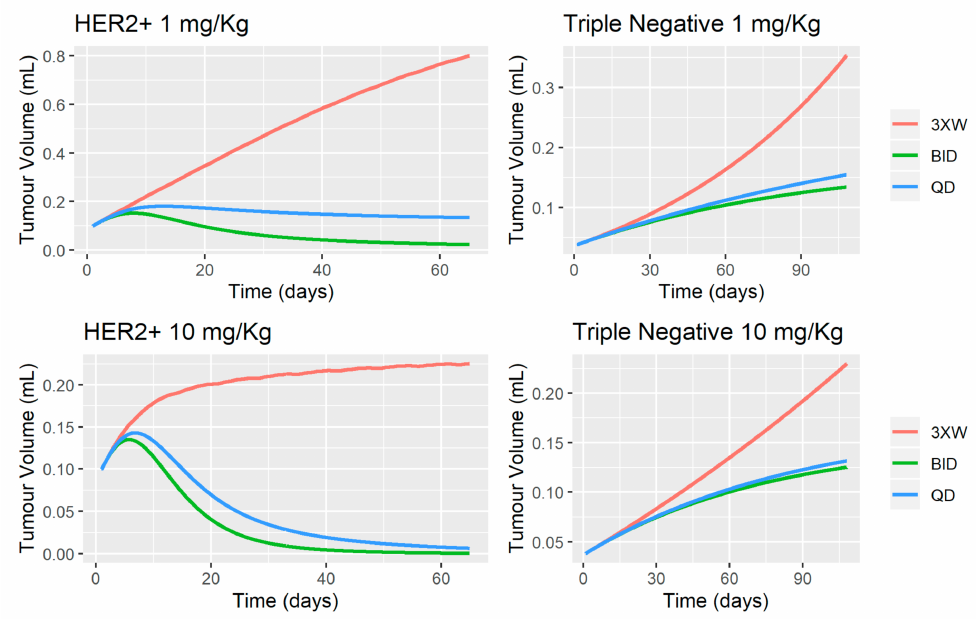
Figure 6. Deterministic simulations to evaluate the impact of intensive dosing strategies on tumor dynamics of HER2 + and Triple Negative cell lines in